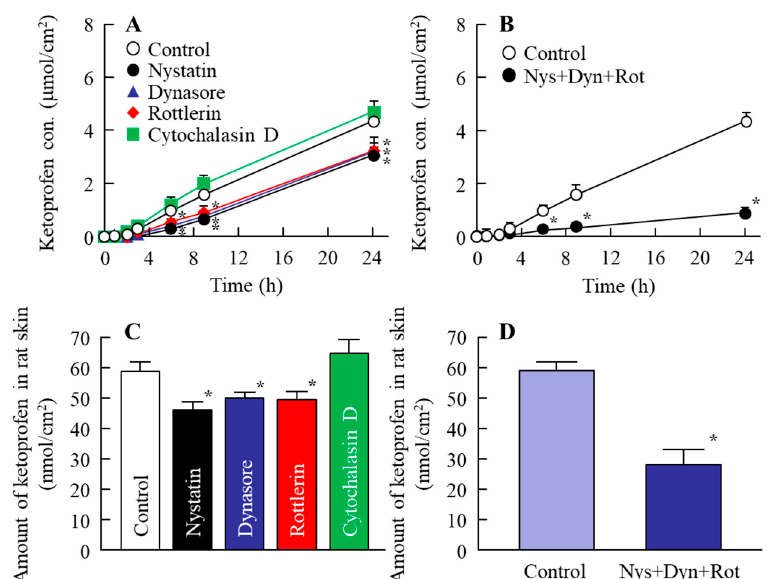
Figure 4. Effect of endocytosis on the transdermal penetration of ketoprofen released from the KET-NPs formulation. ( A ) Effect of endocytosis inhibitors (nystatin, dynasore, rottlerin and cytochalasin D) on the penetration from the KET-NPs formulation through the skin; ( B ) Changes in the transdermal penetration in the KET-NPs formulation by multi-treatment with three inhibitors (nystatin, dynasore and rottlerin; Nys + Dyn + Rot); ( C ) Effect of endocytosis inhibitors (nystatin, dynasore, rottlerin and cytochalasin D) on the amount of ketoprofen in rat skin 24 h after application of the KET-NPs formulation; ( D ) Changes in drug accumulation from the KET-NPs formulation by multi-treatment with three inhibitors (nystatin, dynasore, rottlerin; Nys + Dyn + Rot). The ketoprofen concentration in rat skin was measured 24 h after application of the KE-NPs formulation. Mean ± S.E. n = 6–8. * p < 0.05 vs. control for each category. The transdermal penetration of ketoprofen nanoparticles was promoted by the additive effects of CavME, CME and MP.